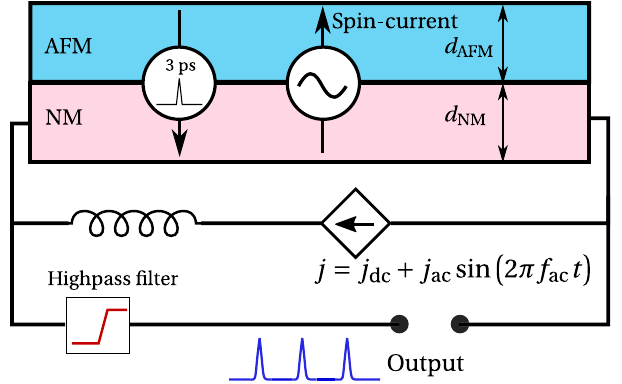
Figure 1. Principal operational scheme of a spintronic generator of ultra short pulses (spikes). A thin antiferromagnetic (AFM) layer is covered by a layer of a normal metal (NM). The NM layer is driven by an ac-modulated electrical current. The output signal is received through a high-pass filter allowing only the frequencies higher than the modulation frequency to get